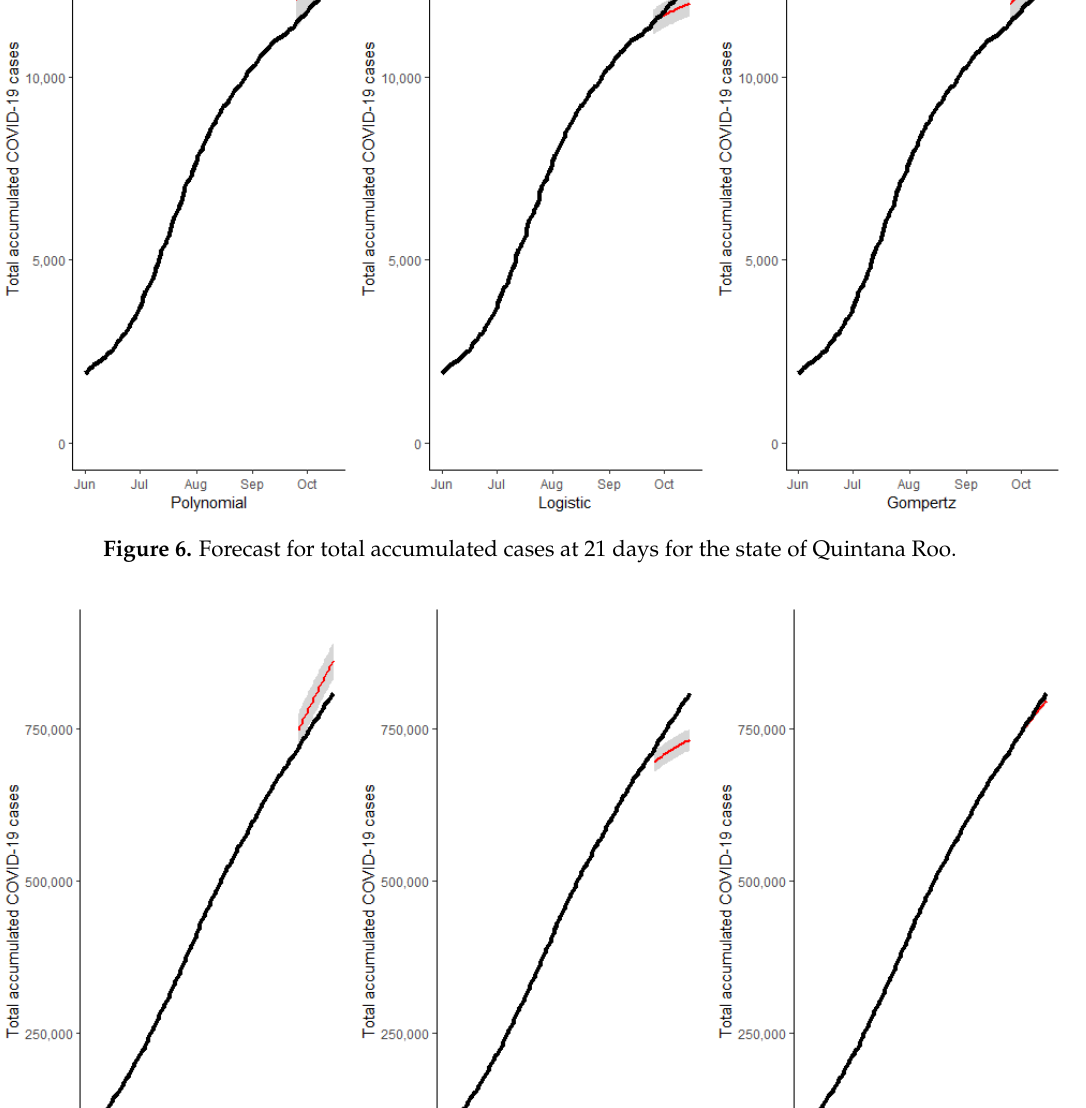
Figure 5. Forecast for total accumulated cases at 21 days for the state of Tamaulipas.